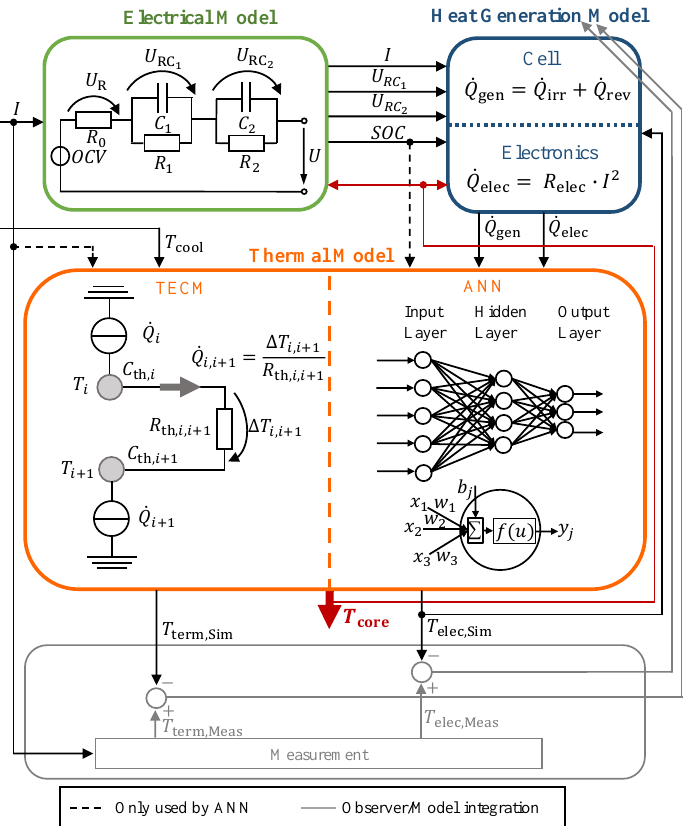
Figure 1. Schematic representation of the modeling framework of an electro-thermal battery cell model, consisting of an electrical, a heat generation, a thermal submodel, and an observer. Two different thermal models are implemented for